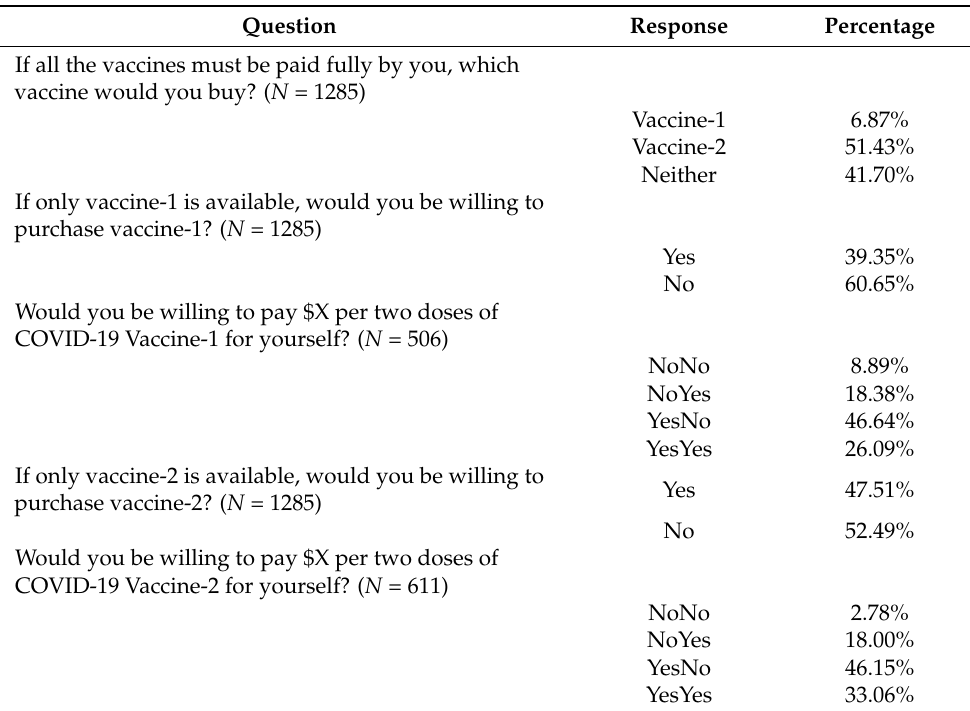
Table 1. Percentages of yes and no answers to willingness to pay (WTP)